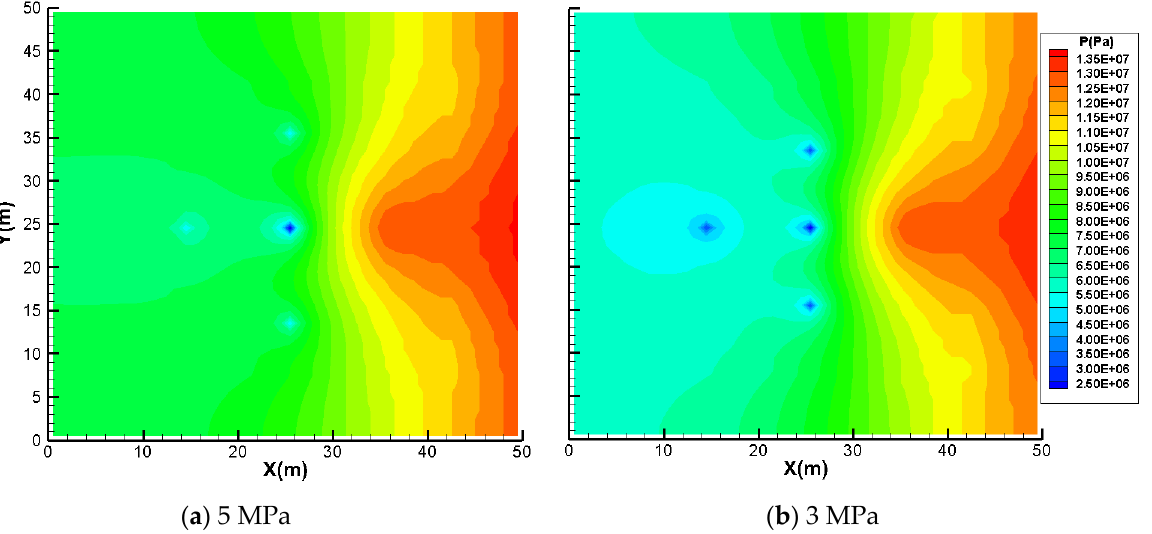
Figure 8. Gas saturation nephogram and groundwater flow traces in the gas flooding pressure of 3 MPa.